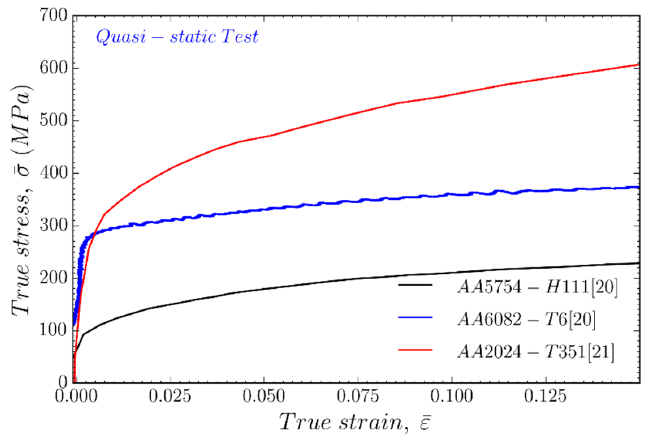
Figure 2. Stress ‐ strain curves of aluminum alloys used. Figure 2. Stress-strain curves of aluminum alloys Table 1. Chemical composition of AA 5754 ‐ H111, AA 6082 ‐ T6, and AA 2024 ‐ T351 (% by weight)